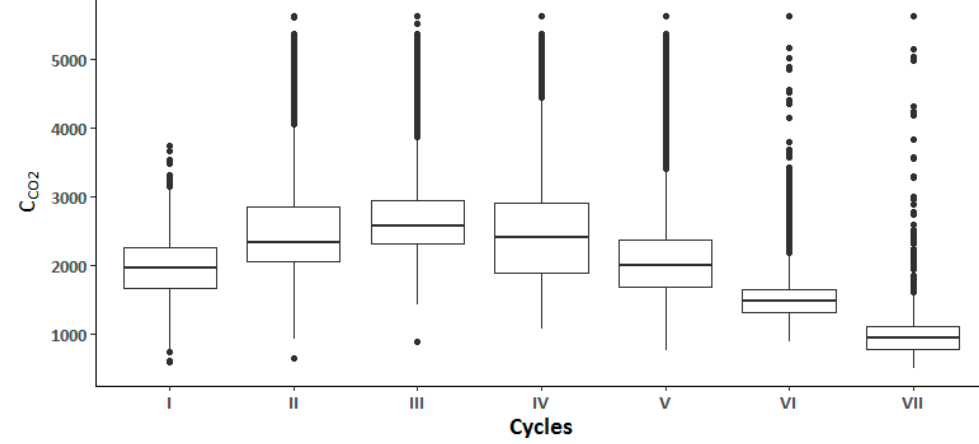
Figure 5. Average CO 2 concentrations in the animal zone (C CO2 ) for each cycle.